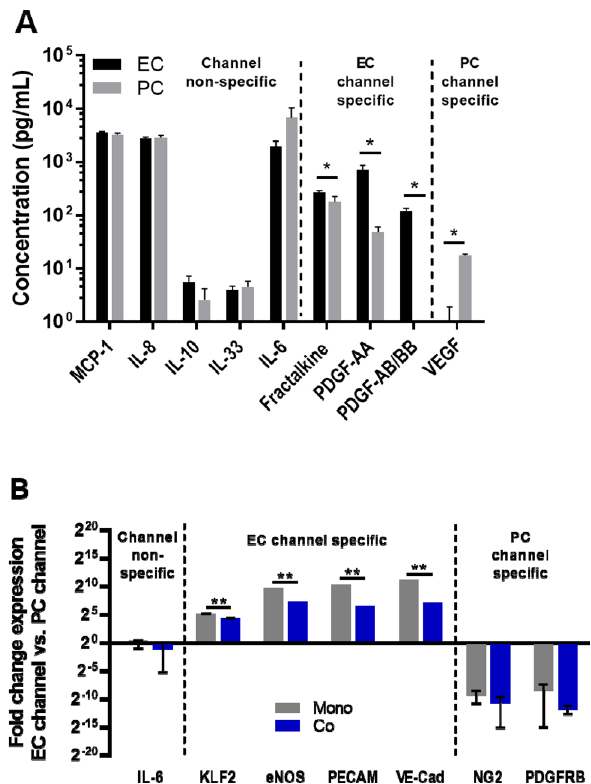
Figure 5. Detection of channel- and cell-type specific responses in PREDICT96 co-cultures. ( A ) Select data shown from 16-plex Luminex kit run on media collected from EC and PC channels after 24 h. Note that some secreted factors are expressed in both channels while others are differentially expressed in EC or PC channels. ( B ) Gene expression for cells isolated from EC and PC channels of devices show that EC markers are significantly enriched in EC channels, while PC markers are significantly enriched in PC channels. Note that IL-6 is expressed by both cell types (secreted and gene). Enrichment of EC markers in the EC channel was significantly decreased in co-culture compared to mono-culture, indicated potential inter-channel